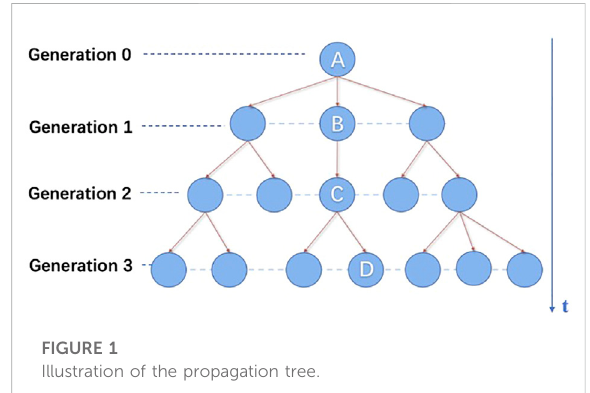
FIGURE 1 Illustration of the propagation